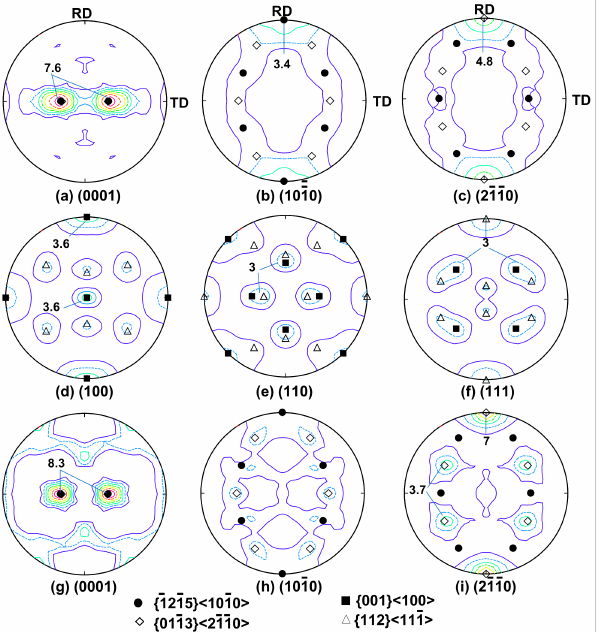
Figure 4. Pole figures of observed textures of CP-Ti, ( a – c ) initial α -hex at 800 ◦ C, ( d – f ) β at 950 ◦ C, and ( g – i ) α -hex at 400 ◦ C after transformation cycle. Contour levels are 1, 2,